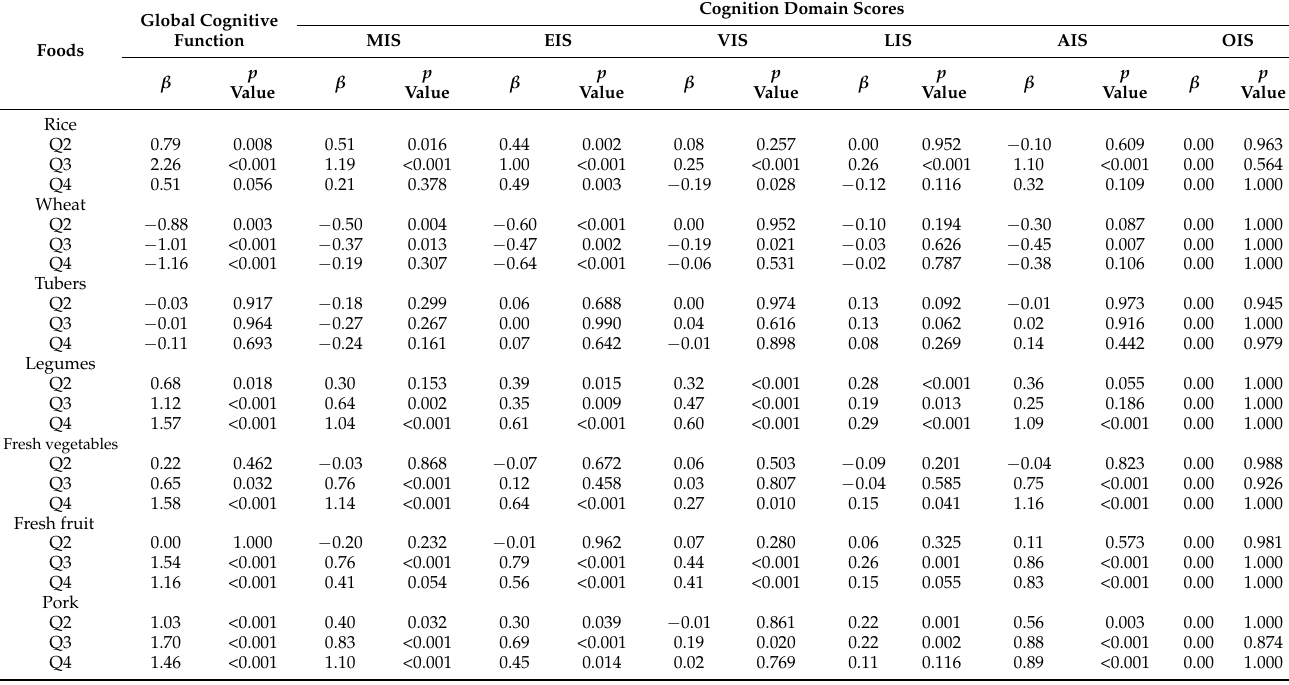
Table 5. Associations of food consumption with global cognitive score and cognitive domain subscores using quantile regression model a